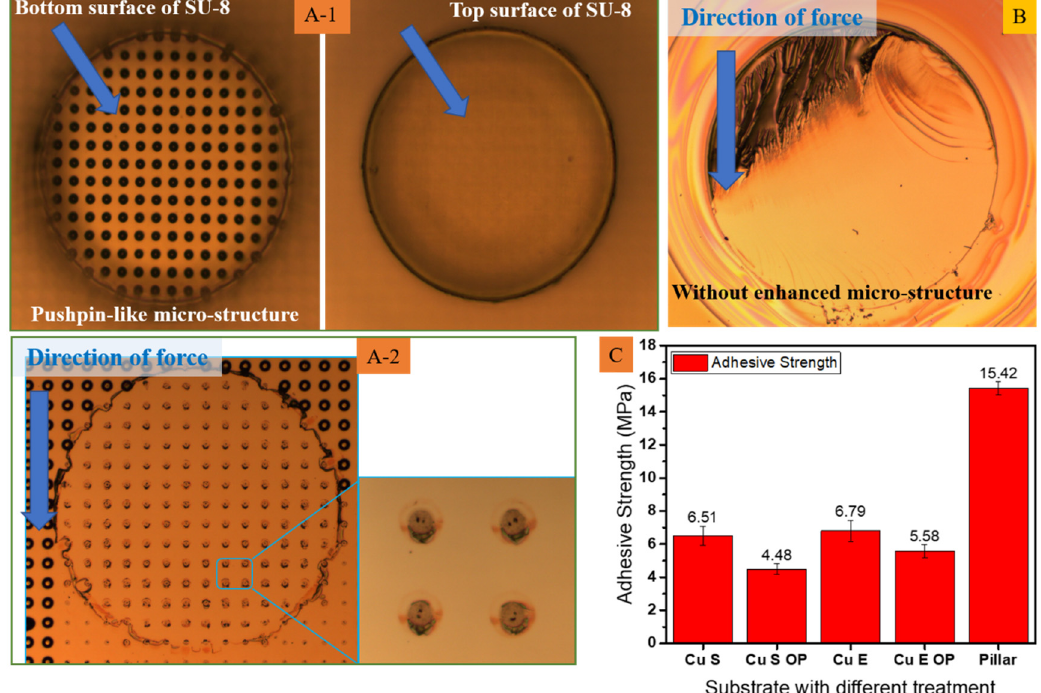
Figure 7. Surface topography of SU-8 with pushpin-like reinforce microstructure array ( A-1 ) before and ( A-2 ) after thrust test. ( B ) Surface topography of normal SU-8. ( C ) Adhesion strength.